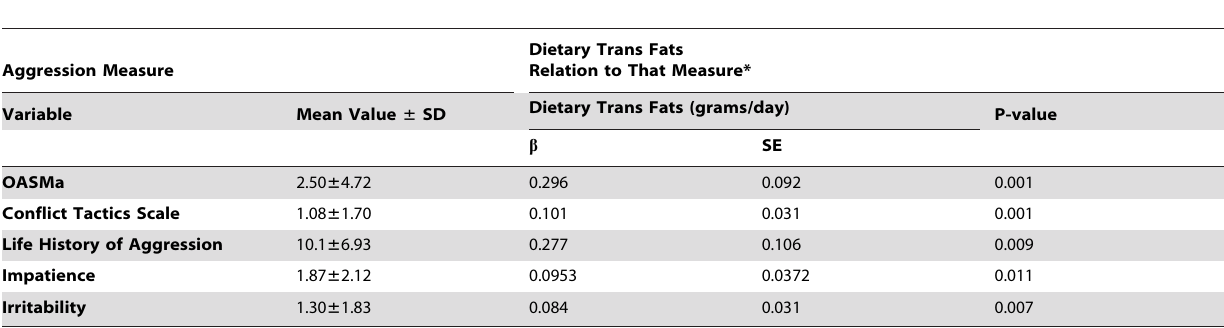
Table 2. Dietary Trans Fat is Significantly Linked to Aggression Measures.